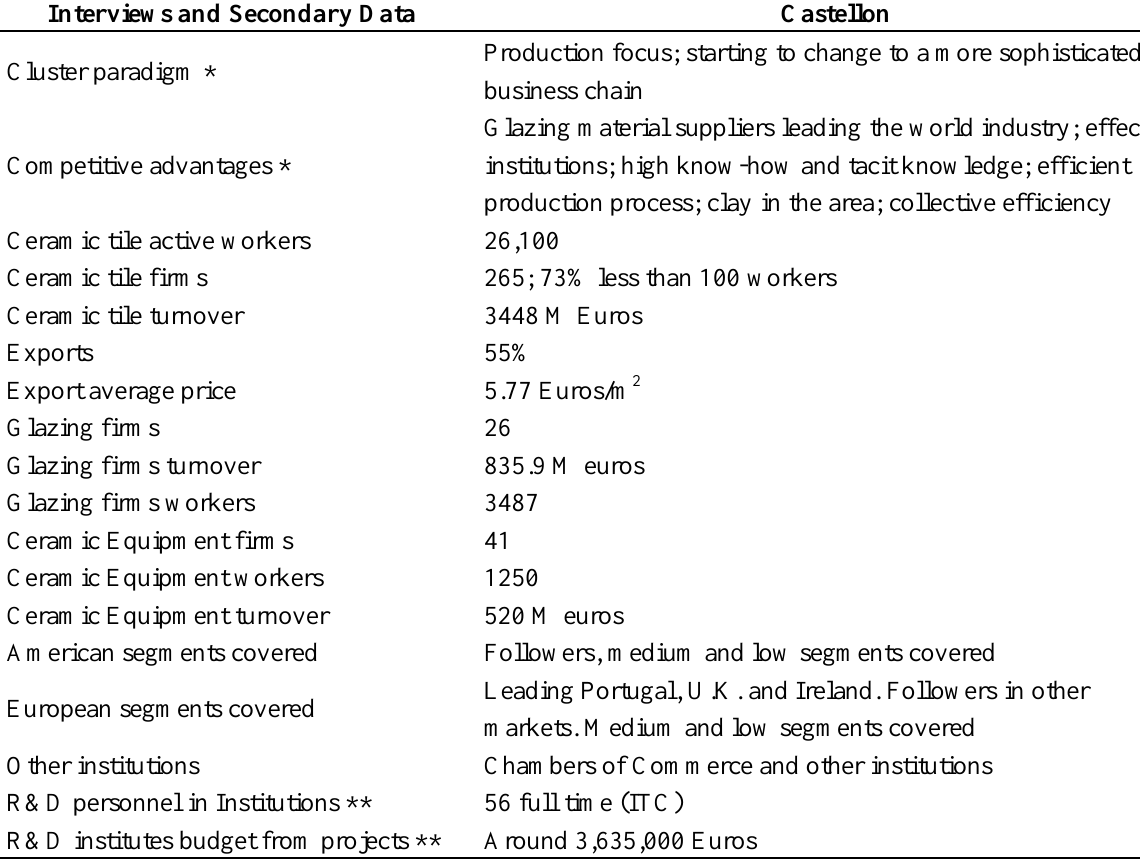
Table 2. Profile of the Spanish tile ceramic cluster